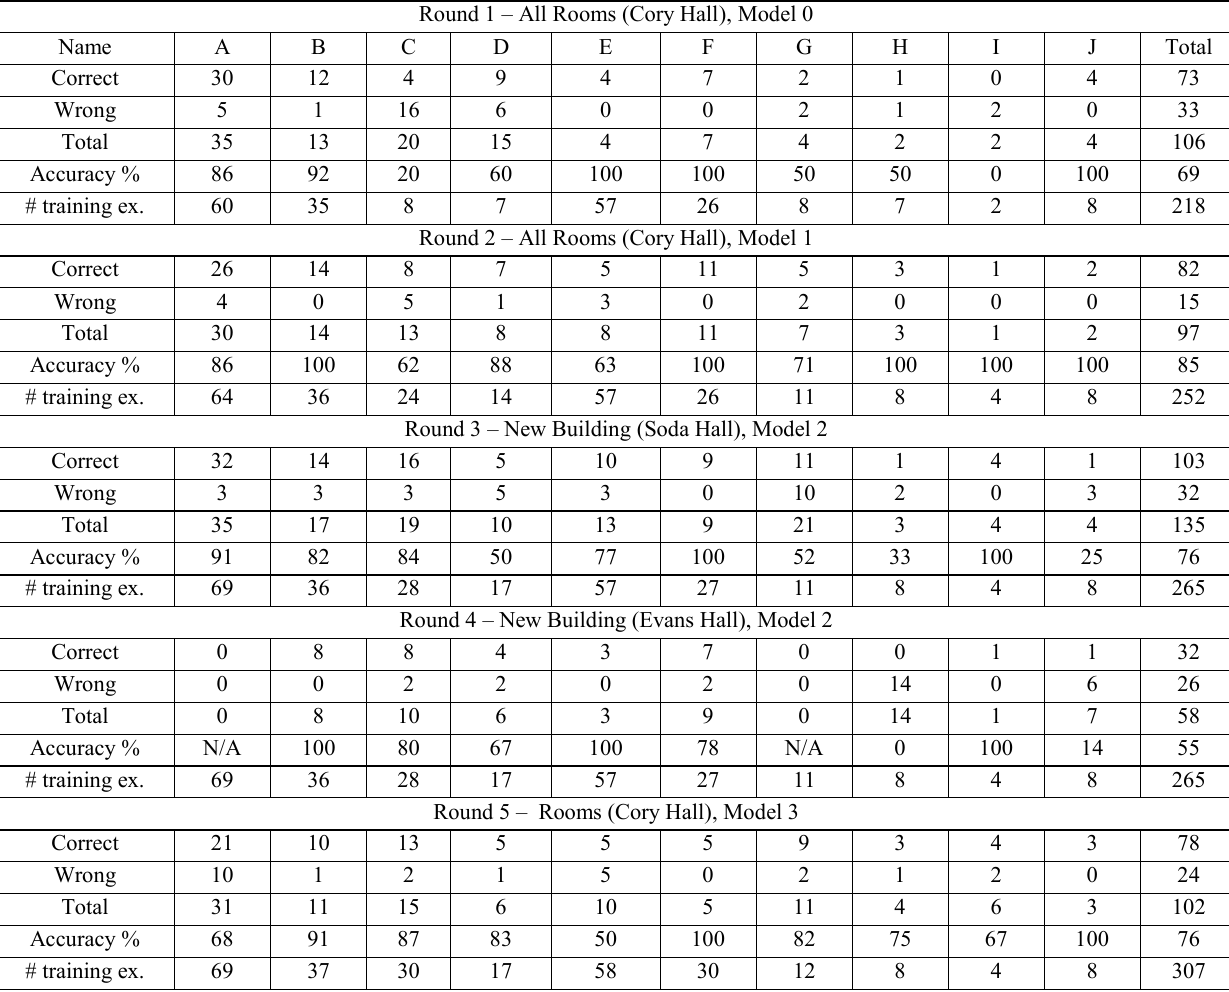
Table 1: A = Fire sprinkler, B = Fire alarm, C = outlet, D = light switch, E = router, F = EXIT sign, G = cardkey reader, H =